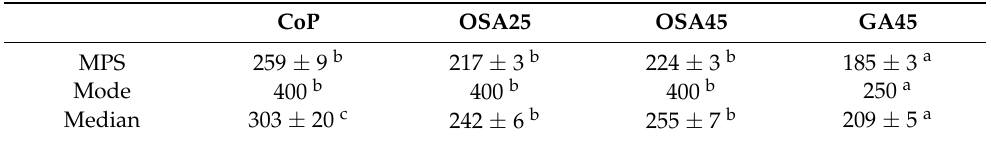
Figure 3. Particle size distribution of the different powder samples (codes according to Table 1) in relation to the percentage of sample retained in each of the sieves (relative frequency, %). Table 4. Mean values of mean particle size (MPS), mode, and median (µm) of the different powder samples (codes according to Table 1).